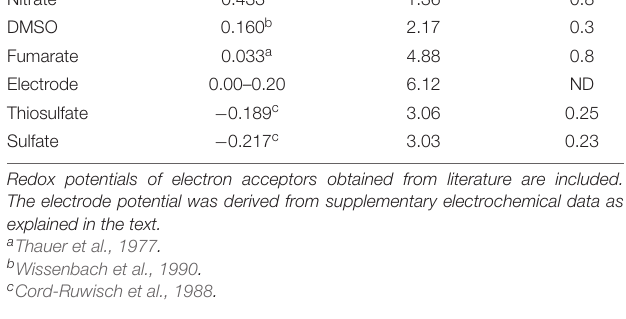
TABLE 1 | Doubling time and maximal OD 600 for communities growing on lactate and different electron acceptors obtained from data in Figure 1 .